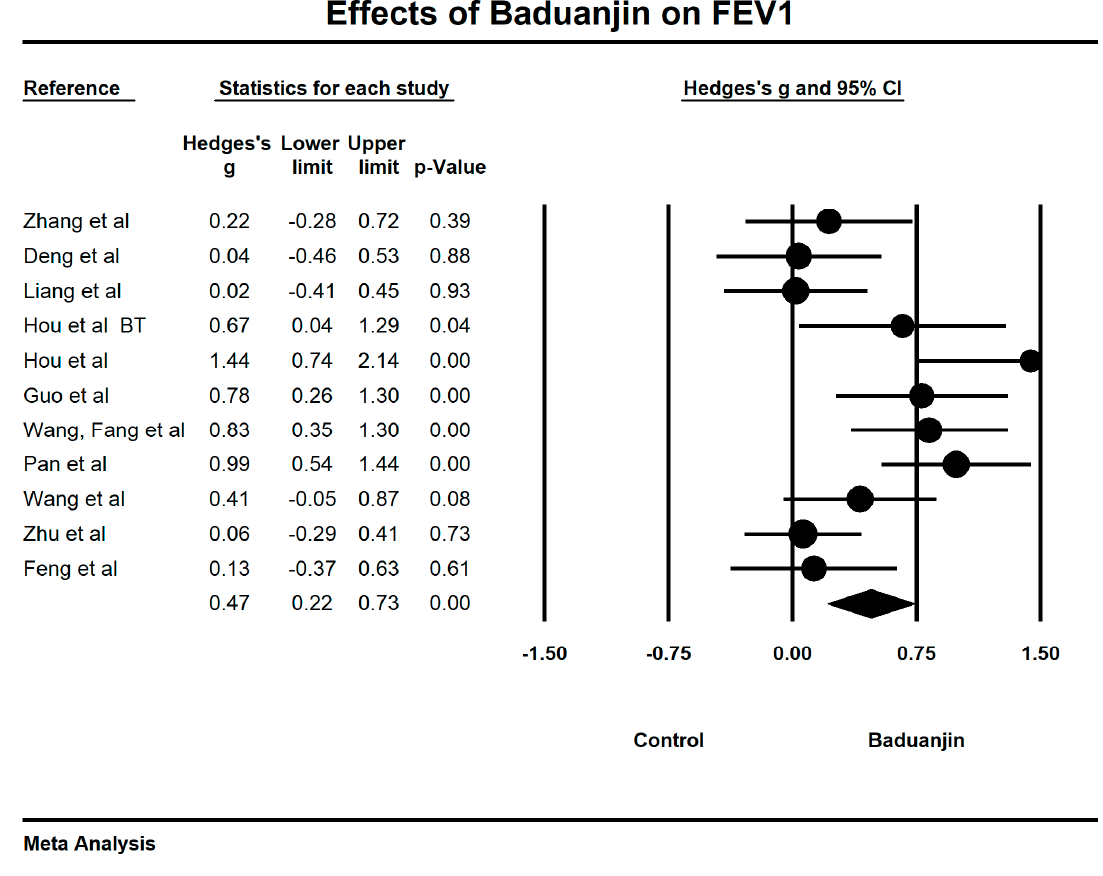
Figure 5. Effect of Baduanjin on FEV 1 (BT = breathing technique training).